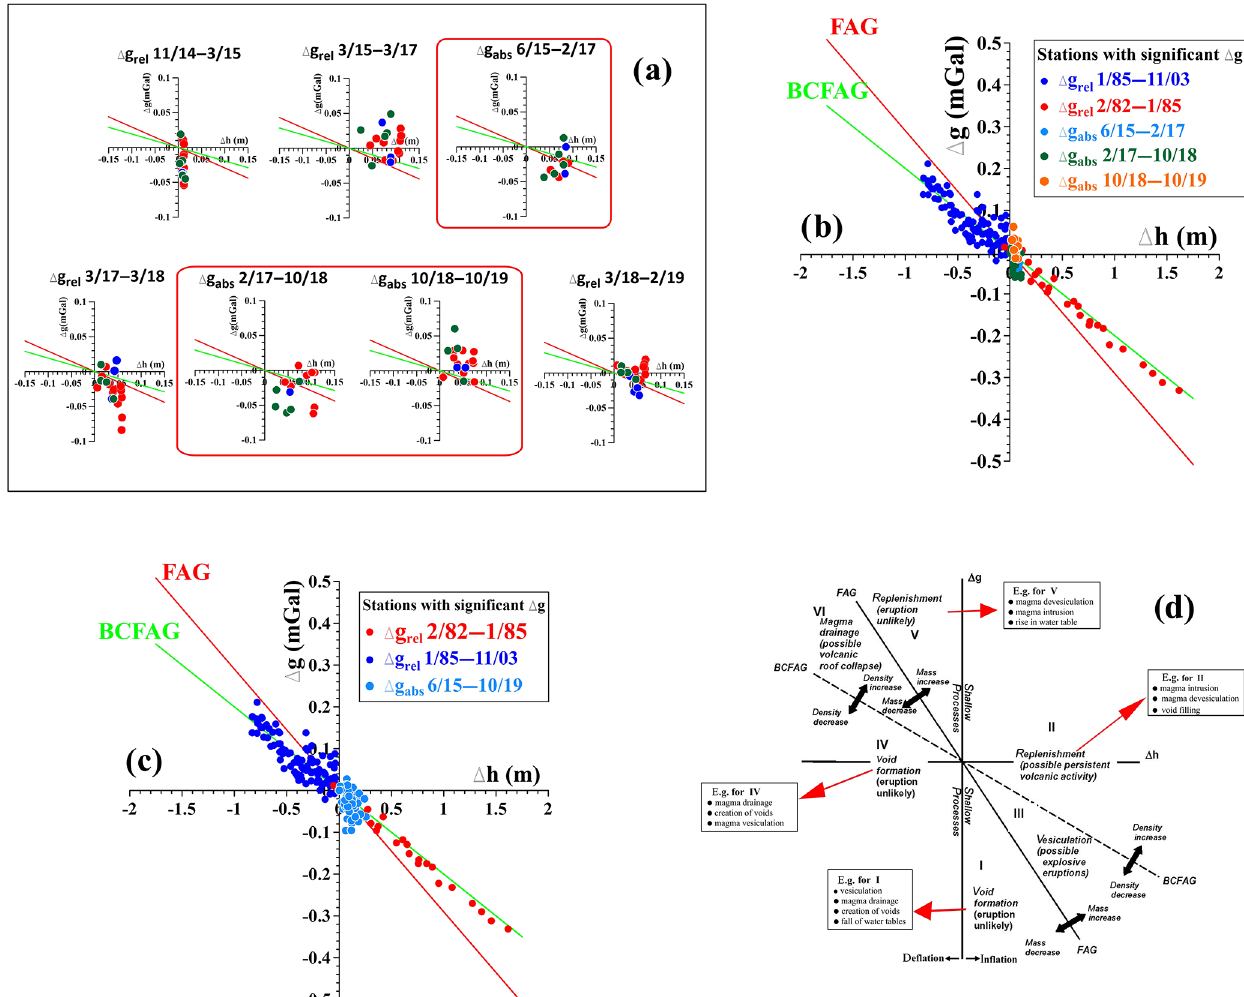
Figure 3. (cid:49)g/(cid:49)h correlation for several time intervals compared with observed Free-air gradient (FAG – red line) and corrected Bouguer gradient (BCFAG – green line). The errors are contained in the size of the symbols. In (a) the (cid:49)g ABS /(cid:49)h regression (enclosed in a red rounded rectangle) on the time intervals of surveys extended to the whole network are shown together to some (cid:49)g REL /(cid:49)h regression close in time. In (b) and (c) the short-term and the cumulative June 2015–October 2019 (cid:49)g ABS /(cid:49)h regressions are compared with the gradients observed during intense uplift and subsidence phases. In (d) the diagram for interpreting the variations in gravity/height changes ( (cid:49)g/(cid:49)h ) in terms of mass changes (after Brown and Rymer, 1991; Berrino et al., 1992; Gottsmann et al., 2003) is also inserted; it is the combination of the diagrams in the two last mentioned papers (for all see text for